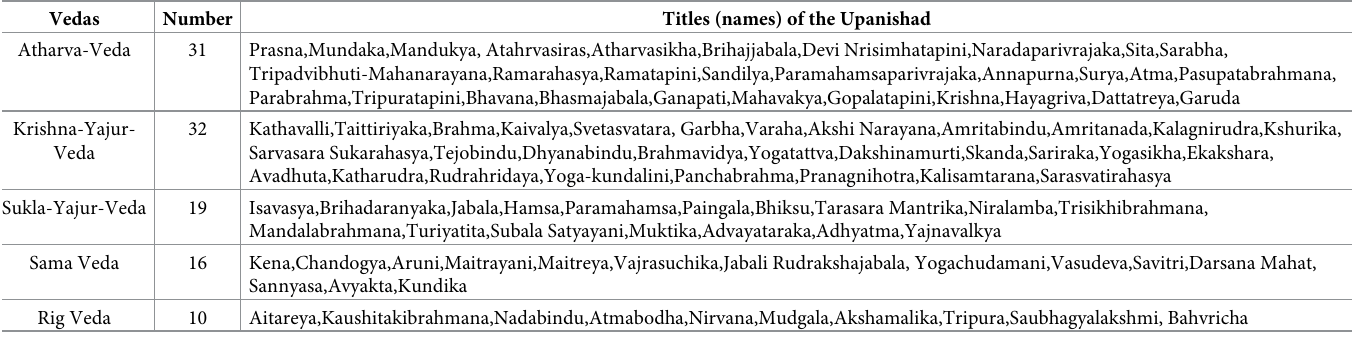
Table 7. Classification of 108 Upanishads based on the four key Vedas. Note that the original Yajur Veda is divided into two parts (Krishna- Yajur-Veda and Sukla- Yajur-Veda). Vedas Number Titles (names) of the Upanishad